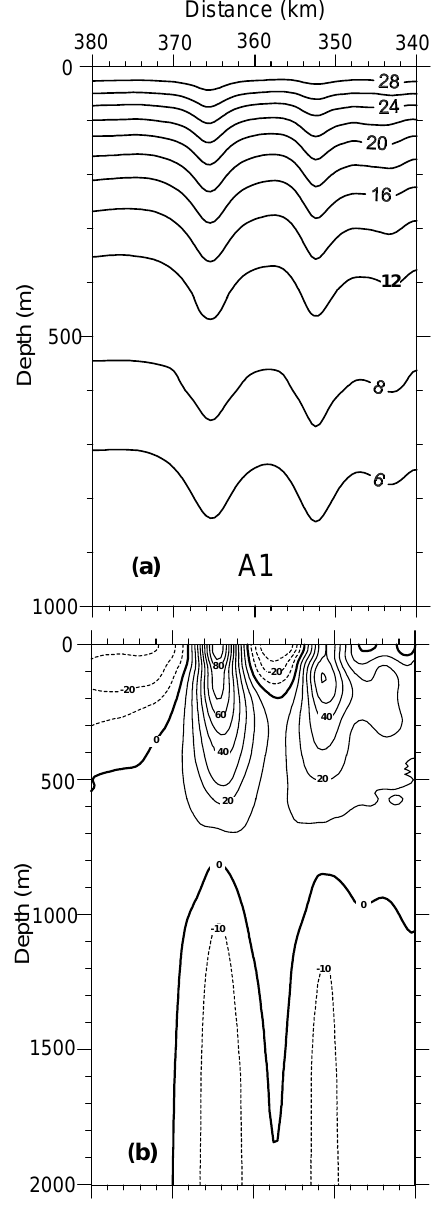
Fig. 5. A pair of first-mode solitary waves located in the rectangle A 1 shown in Fig. 4b. Panel (a) shows the temperature field ( ◦ C) and panel (b) depicts the horizontal velocity field (cms − 1 ).